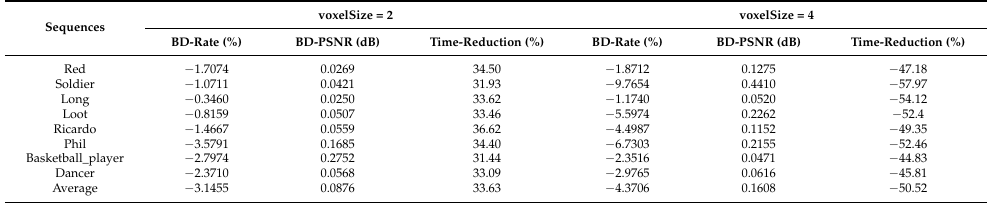
Table 2. The BD-rate, BD-PSNR in geometric component, and runtime for our method compared with V-PCC.